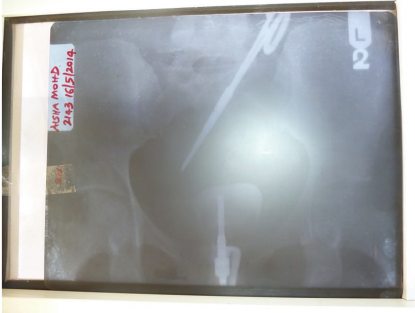
Figure 1: Hysterosalpingogram showing retained surgical clamp.